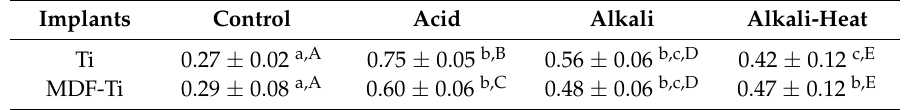
Table 2. Three-dimensional arithmetic mean height (Sa) of surface-treated implants ( µ m). Implants